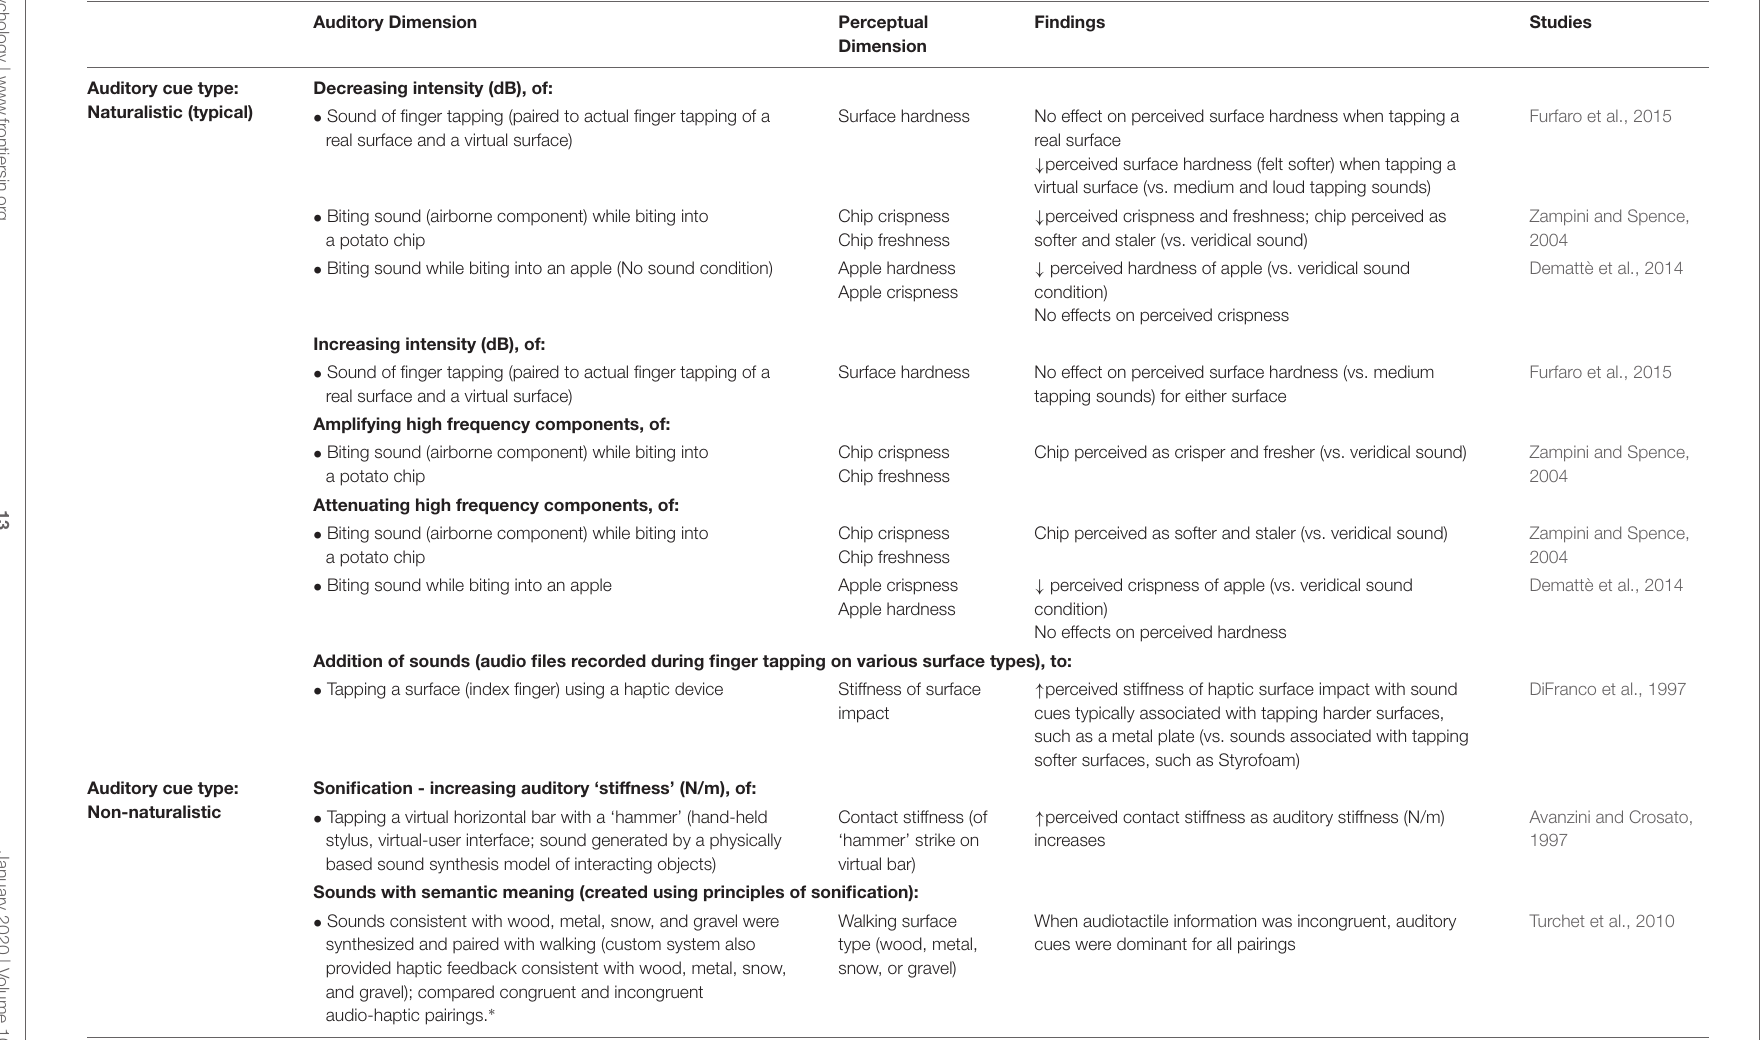
TABLE 4 | Summary of the effects of non-veridical auditory cues on surface contact properties. Auditory Dimension Perceptual